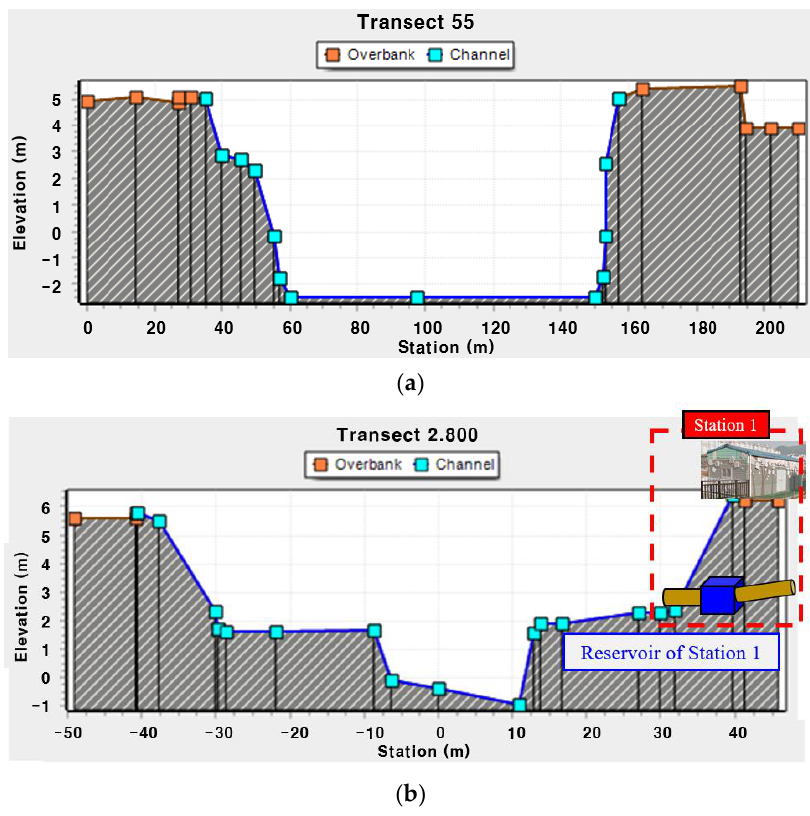
Figure 11. Cross-sectional view: ( a ) Location 1; ( b ) Location 2.